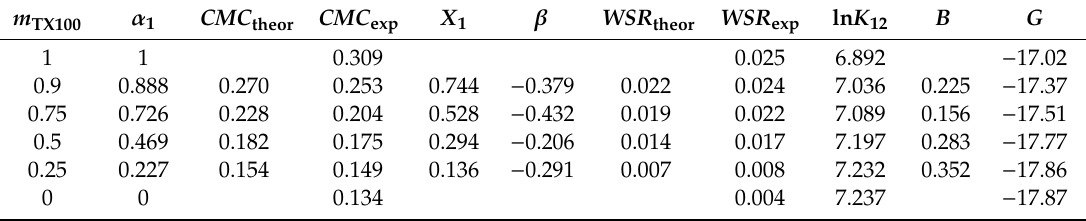
Table 2. Solubilization parameters, critical micelle concentration CMC, interaction parameter,